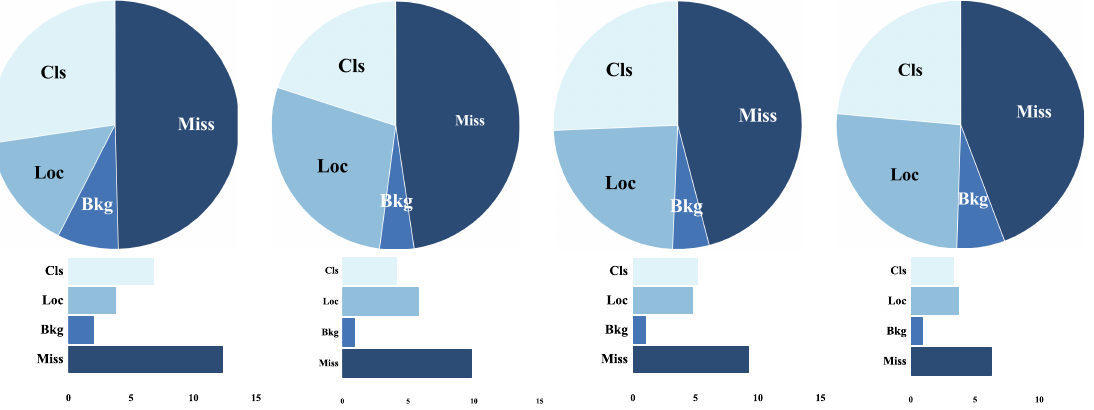
Figure 11. Error analysis. Results are reported using the Pascal VOC → Clipart setup. Four types: Cls (classification error), Loc (localization error), Bkg (background error), and Miss (missed GT error). From left to right, it is source only, feature alignment branch only, feature suppression branch only, and DAB,